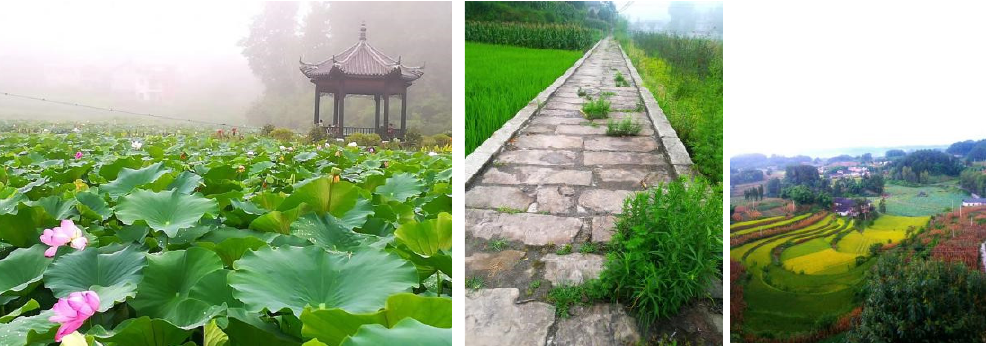
Figure 7. The lotuses, connecting trails, and pastoral scenery in Anzhen Village (source: Taken by the author).